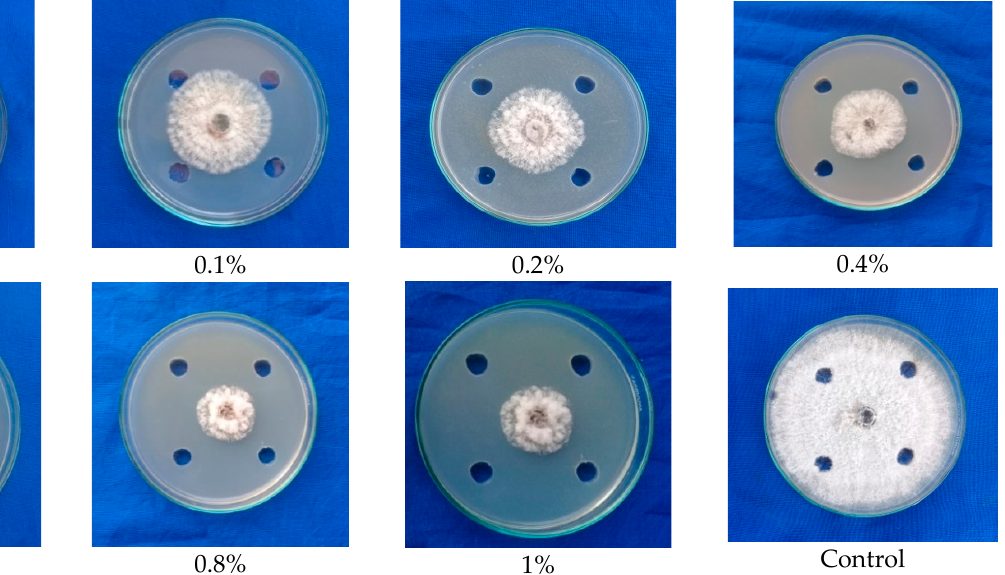
Figure 1. Production of the fruiting body of G. lucidum. ( A ) Elongation of stipe; ( B ) expansion of fruiting body; and ( C ) bracket-shaped fruiting body.